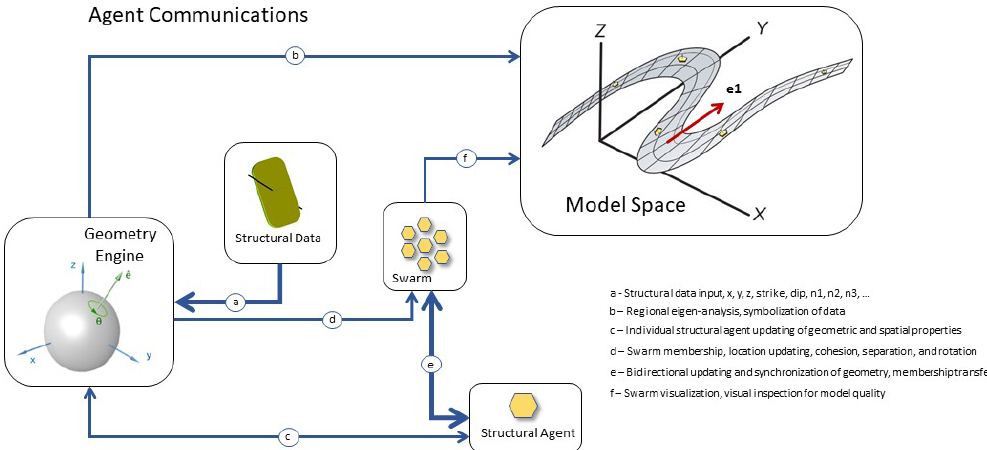
Figure 5. General summary of structural agent communication using the example from GeoSwarm ; for details, see comments and codes in the open-source programs listed in Appendix B. The thickness of the blue lines indicates the relative degree of inter-agent communication. The geometry engine is composed of all agent functions for determining eigen-directions, proximity, rotation, location, and spatial estimation. The grey fold surface in model space represents a possible fold realization that emerges from swarming structural agents, given sparse input data (yellow markers). The red arrow indicates the principal eigenvector direction, which is also the fold hinge or regional plunge; this can be used as a rotation axis for updating the structural agent